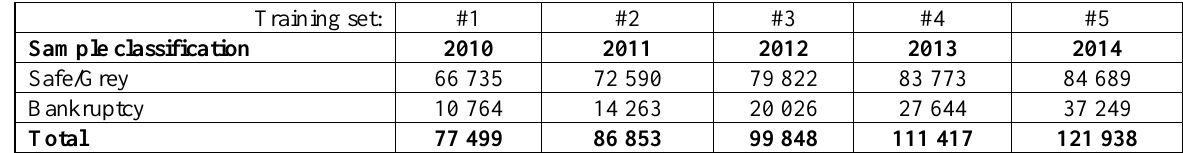
Table 4. Training sets for Bankruptcy prediction using ML-approach